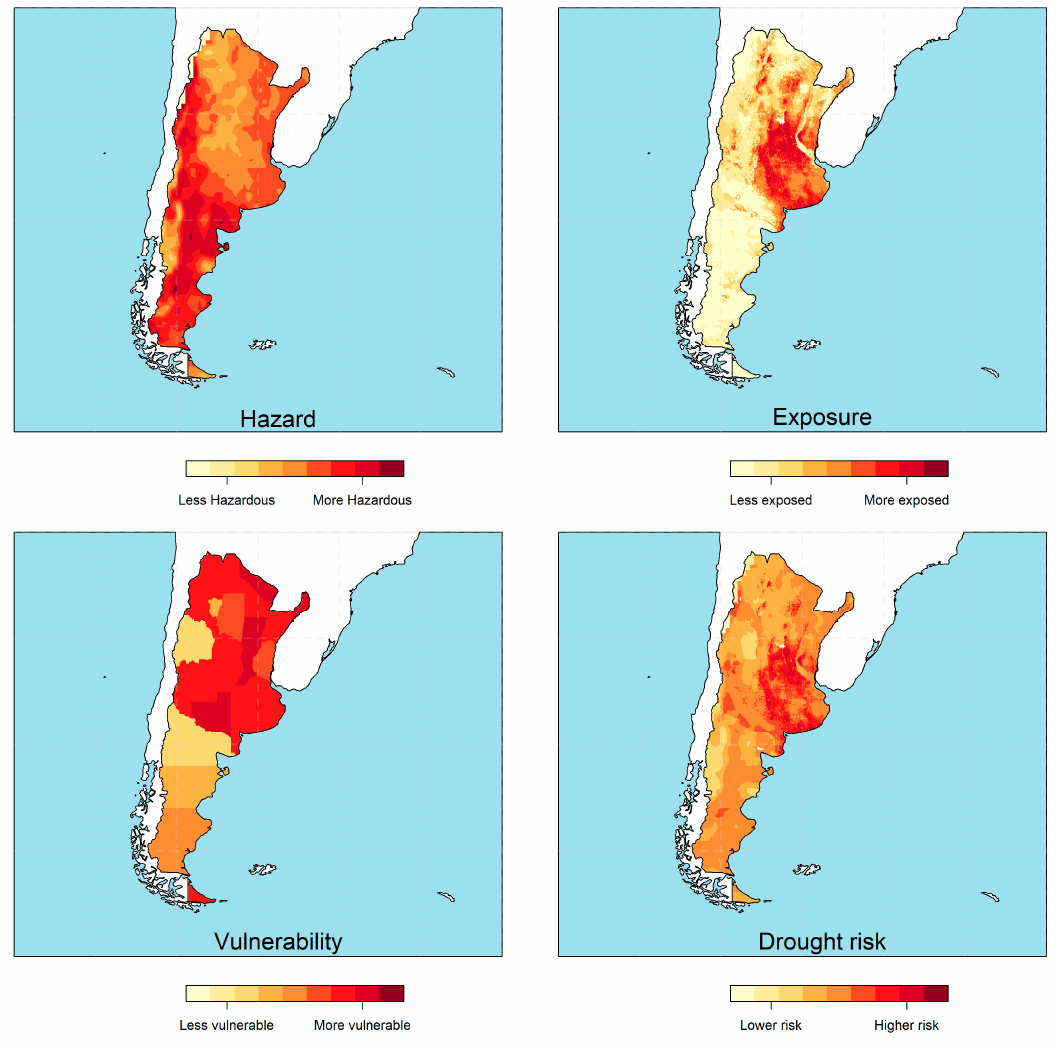
Figure 1. Drought hazard, exposure, vulnerability and the overall drought risk for Argentina.